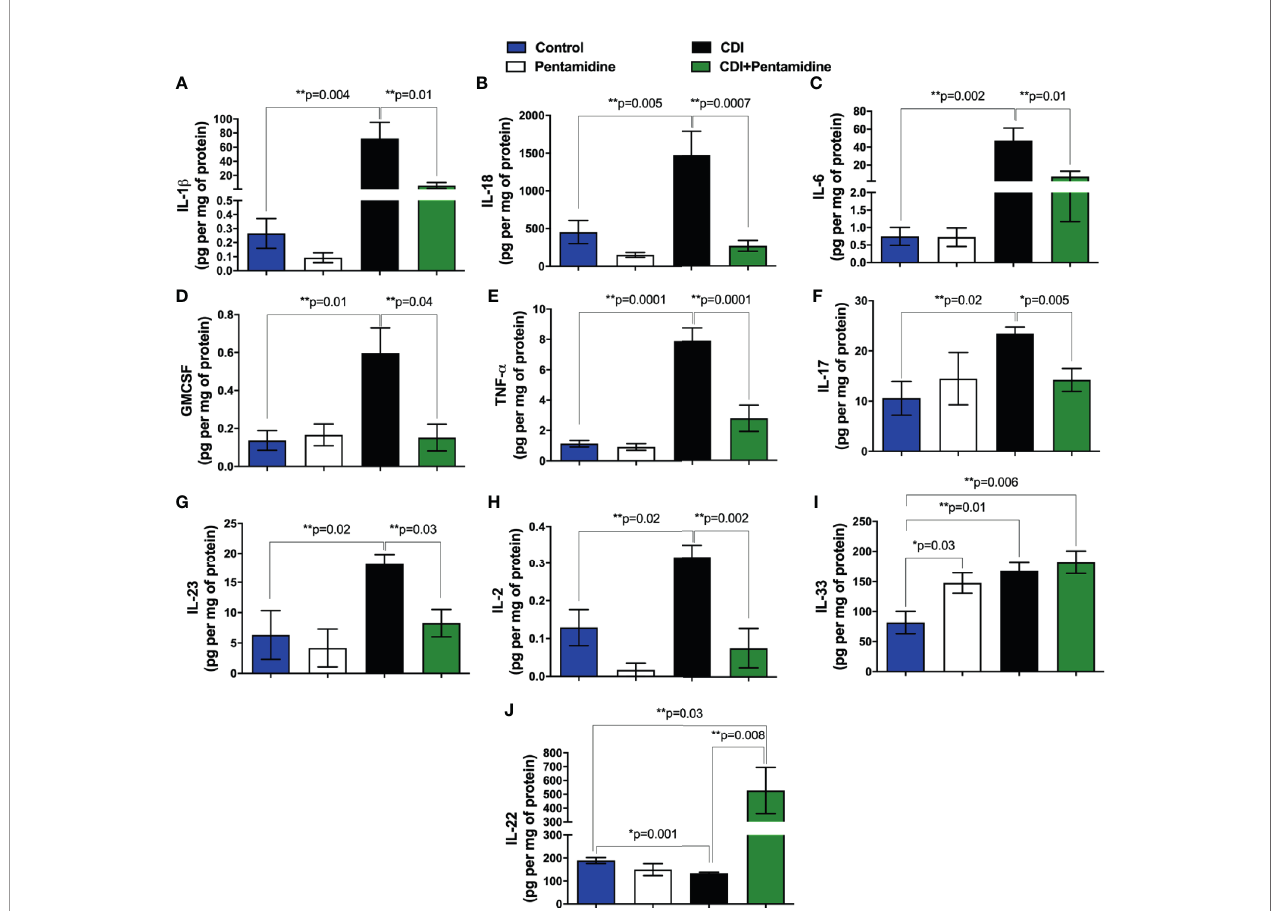
FIGURE 3 | S100B modulates the release of pro-in fl ammatory mediators and tissue repair cytokines during CDI in mice. Levels of (A) IL-1 b , (B) IL-18, (C) IL-6, (D) GMCSF, (E) TNF- a , (F) IL-17, (G) IL-23, (H) IL-2, (I) IL-33, and (J) IL-22 in colonic tissues from uninfected (control), uninfected receiving pentamidine (40 mg/kg, pentamidine), non-pretreated C. dif fi cile -infected (CDI), and pentamidine-pretreated C. dif fi cile- infected (CDI+pentamidine) mice at day 3 p.i. were measured by ELISA. Data are mean ± s.e.m. **ANOVA followed by Turkey test was used. *Unpaired two-tailed Student ’ s t